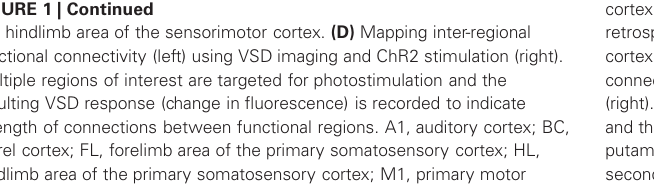
A method for in vitro functional circuit mapping based on laser scanning photostimulation (LSPS), where the connections between presynaptic ChR2-expressing cells and postsynaptic neurons are mapped using whole-cell recordings (Petreanu et al.,